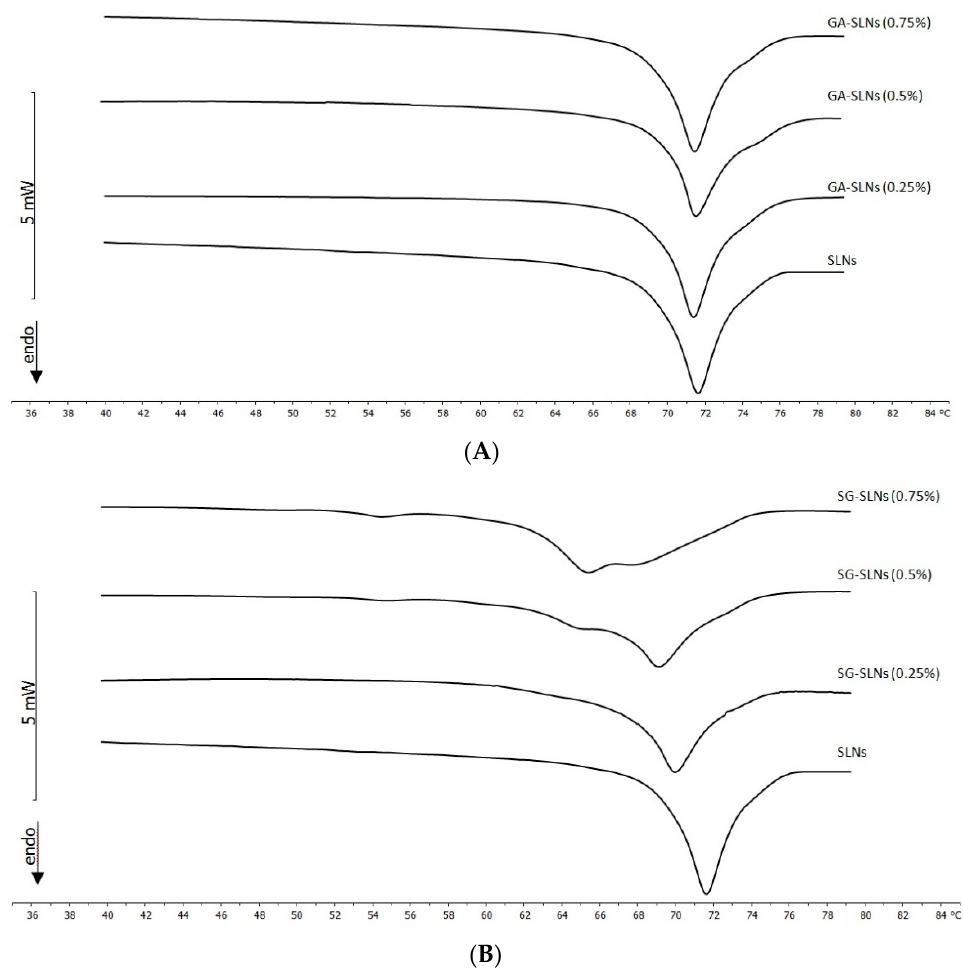
Figure 4 . ( A ) Calorimetric curves, in the heating mode, of GA-SLNs. ( B ) Calorimetric curves, in the heating mode, of SG-SLNs.